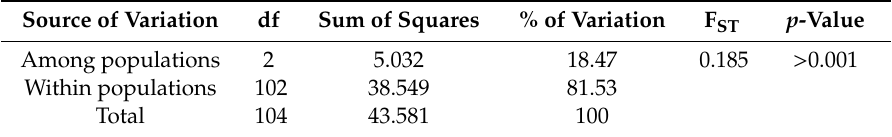
Figure 4. Median-joining haplotype network for COI sequences. Different colors correspond to geographic origin and circle size is proportional to the number of individuals with the same haplotype. Hatch marks along edges represent the number of mutations between nodes. Accession numbers for individuals representing each haplotype are given in Table S3. Table 3. Results from AMOVA analysis for the CR gene.